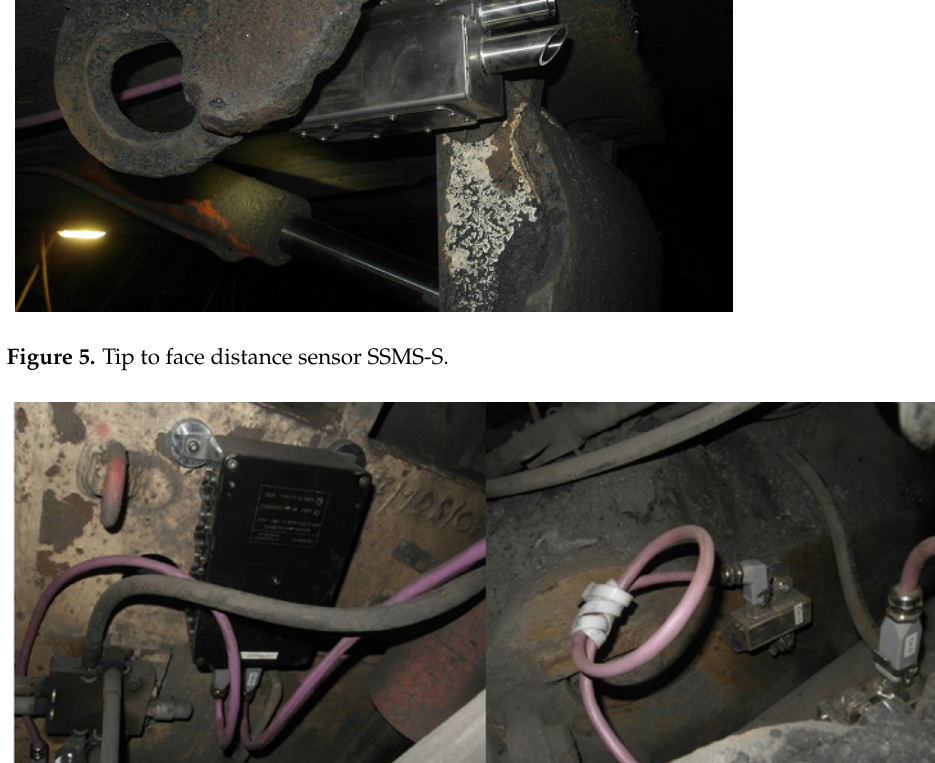
Figure 8. SSMS-S 23 August 2020 roof support No. 116. 2.4. Field Test of SMMS at JSW Budryk Mine The full testing programme was finally realized at Budryk Mine (Figure 9). For technical reasons, it was not possible to take a photo of the sensor during testing at the mine. Figure 9. Model of the SSMS-S sensor installed on the BW 24/44 POz roof support canopy during preparatory work for the mining process, at the manufacturer’s site. During tests, KOMAG developed the visualization module especially dedicated for presentation of the geometry and pressure monitoring data. The measurement results are shown in Figures 10 and 11. The figures show the corrupted tip-to face distance data. The